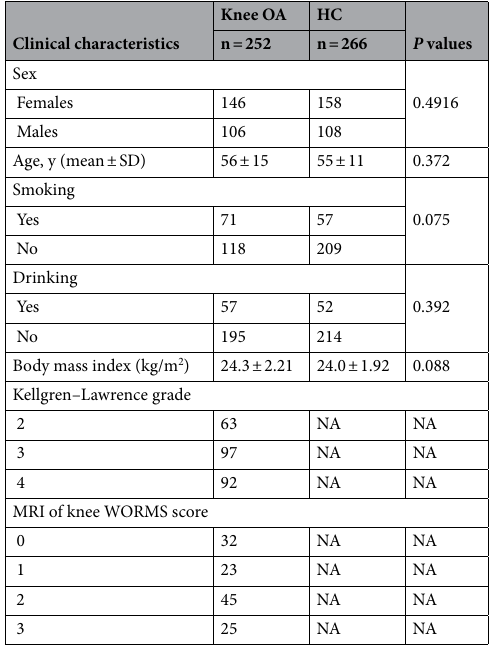
Table 2. Demographics and clinical characteristics of participants for TLR7 SNP. Knee OA knee osteoarthritis patients group, HC healthy control group, SD standard deviation, NA not assessable, WORMS Semiquantitative whole-organ MRI scoring.